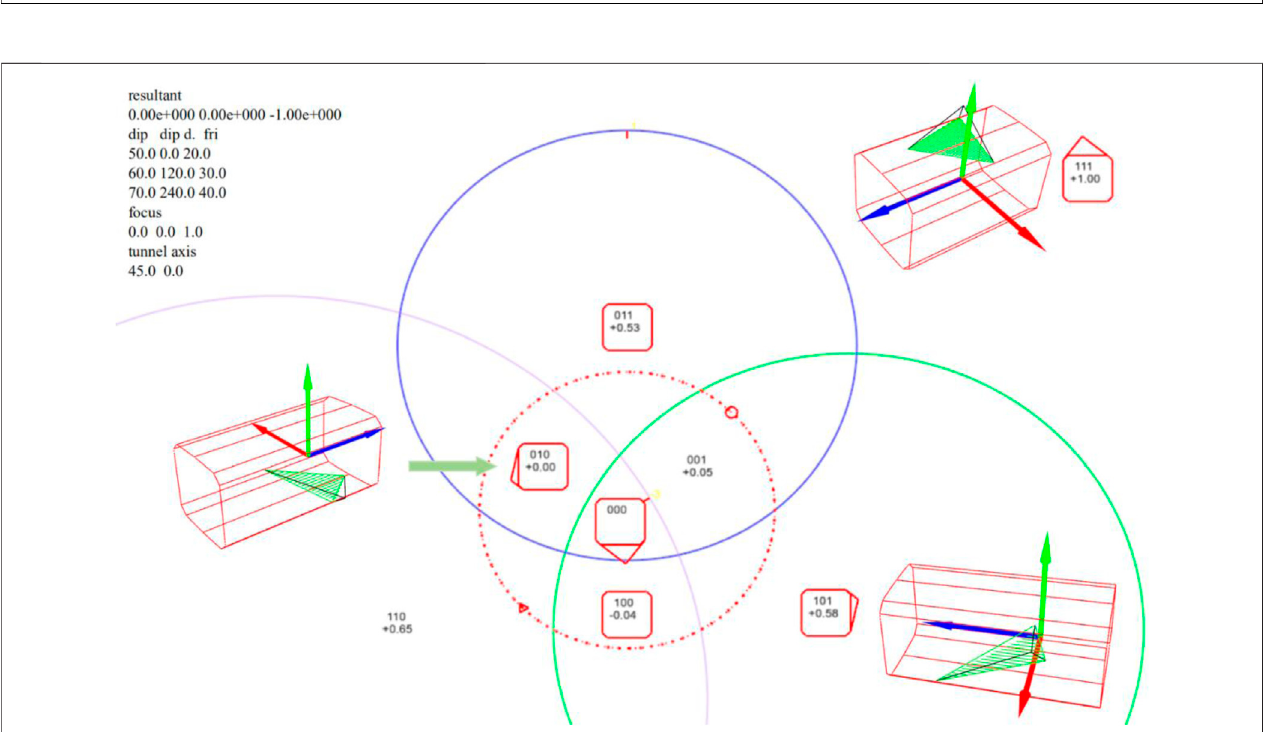
FIGURE 2 | Joint pyramid and